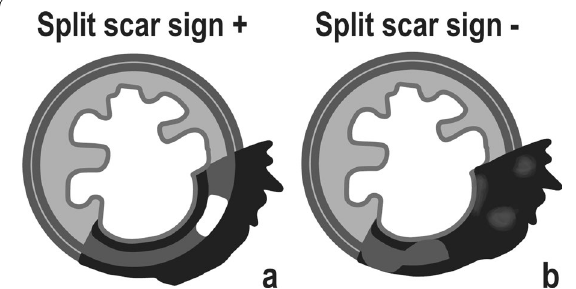
Fig. 5 The split scar sign is considered present or positive ( a ) when a thin 1–2 mm regular layer of hypointense “fibrosis” is present at the endoluminal aspect of the tumour bed (corresponding to the fibrosed submucosa), underlined by homogeneous intermediate signal (corresponding to a thickened and partially fibrotic muscularis propria), covered or not by a usually irregular hypointense layer of perirectal fibrosis. In mucinous or mucin-degenerated tumours, the middle intermediate signal intensity layer may be replaced with homogeneously high signal intensity, corresponding to mucin pooling. Whenever the tumour bed is not “organised” in such a layered manner (such as with full thickness “black” scars) or whenever it is but the inner and/or outer “fibrotic walls” are focally breached, the sign should be considered absent/negative ( b )